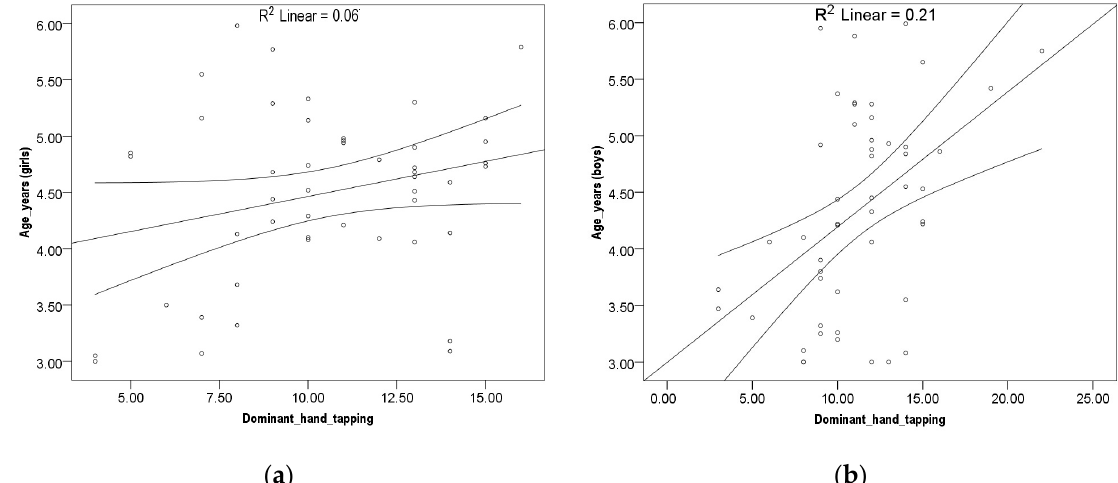
Figure 1. ( a ) Hand tapping girls. ( b ) Hand tapping boys.